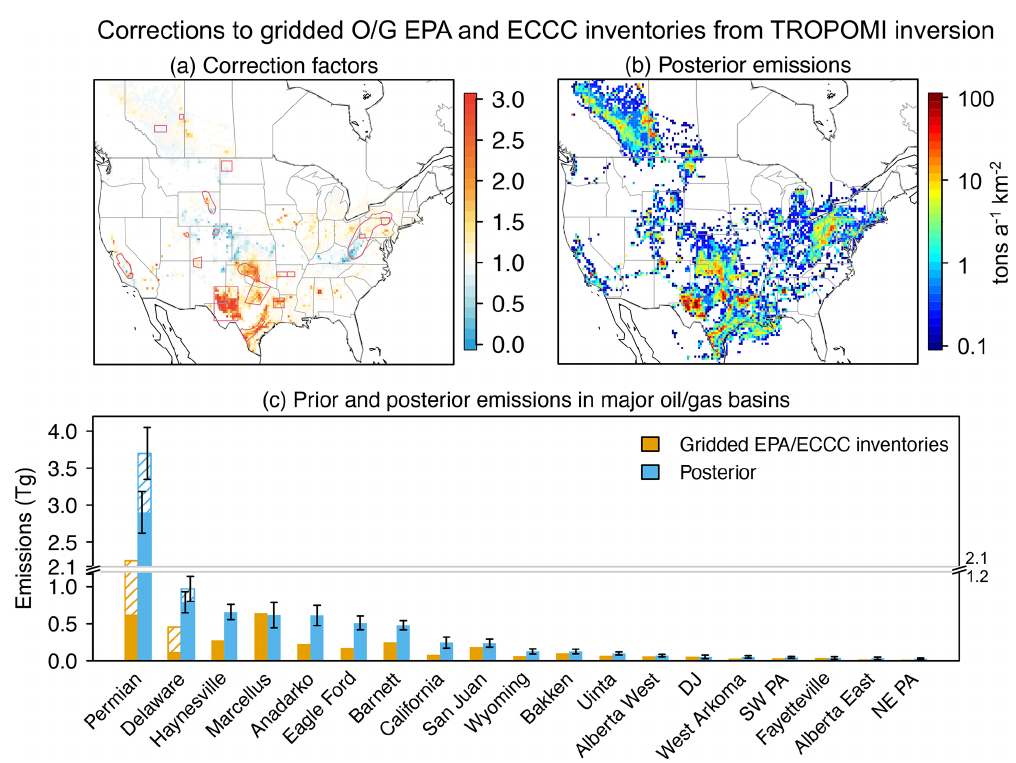
Figure 2. Corrections to oil and natural gas methane emissions in the US EPA and Canadian ECCC national inventories from the inversion of TROPOMI methane observations (May 2018–February 2020). (a) Posterior correction factors to the gridded national inventory estimates shown in Fig. 1b and used as prior estimates in the inversion. The boundaries of the 19 major O / G basins are shown on the map, and the names of these basins can be found in Fig. S11. (b) Posterior O / G methane emissions. For panels (a) and (b) , grid cells with prior O / G emissions < 0 . 1 metric tona − 1 km − 2 are shown in white (consistent with Fig. 1b). (c) Prior and posterior emissions in the 19 oil and gas basins, arranged in decreasing order of posterior emissions. Delaware is a subregion of the Permian Basin. Vertical bars indicate the 2 × error standard deviations from the inversion ensemble. Striped bars for the Permian and Delaware basins show the results of an inversion where the prior estimate of emissions from the oil and gas production sector was increased by a factor of 4 from the EPA inventory, reflecting previous evidence that the EPA inventory is too